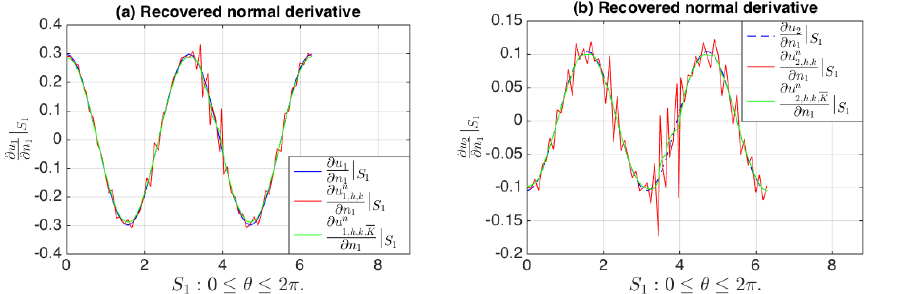
Figure 3. ( a ) Plots of exact normal derivative of u 1 and its approximations with and without sequential smoothing corresponding to input data without error V , using mesh M 1 of circular region. ( b ) Plots of exact normal derivative of u 2 and its approximations with and without sequential smoothing corresponding to input data without error V , using mesh M 1 of circular region.